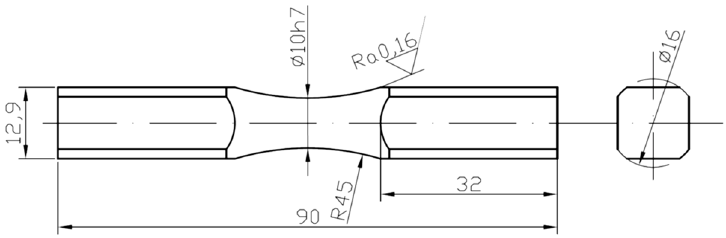
Figure 1. Shape and dimensions (in millimetres) of the specimen of the analyzed materials used in fatigue tests.